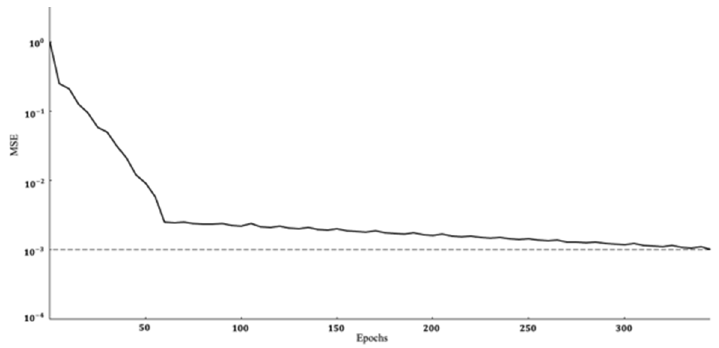
Figure 5. Convergence process of Elman neural network.